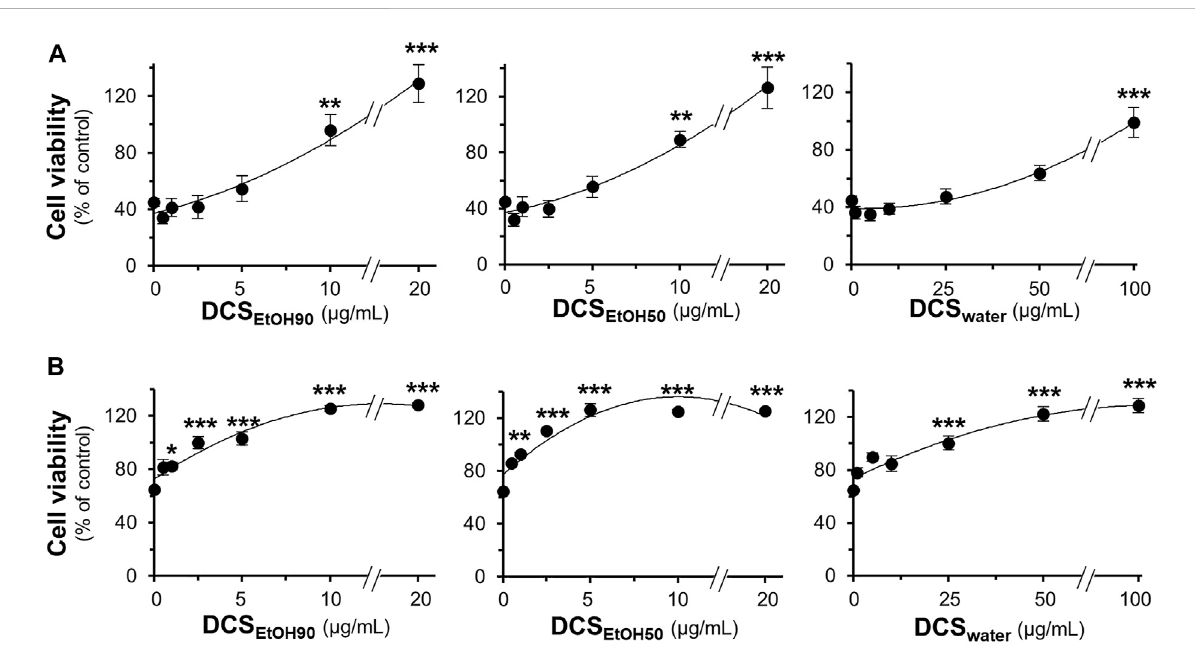
FIGURE 5 D.cochinchinensis stemwoodextracts preventA β -inducedcell death. (A) A β (0.1 – 20 μ g/ml), DCS EtOH50 (0.1 – 20 μ g/ml), or DCS water (1 – 100 μ g/ml) at 37 ° C for 6 days were applied to cultured PC12 cells for 24 h (B) PC12 cells werepre-treatedwithextractsfor24 hbeforeexposuretoA